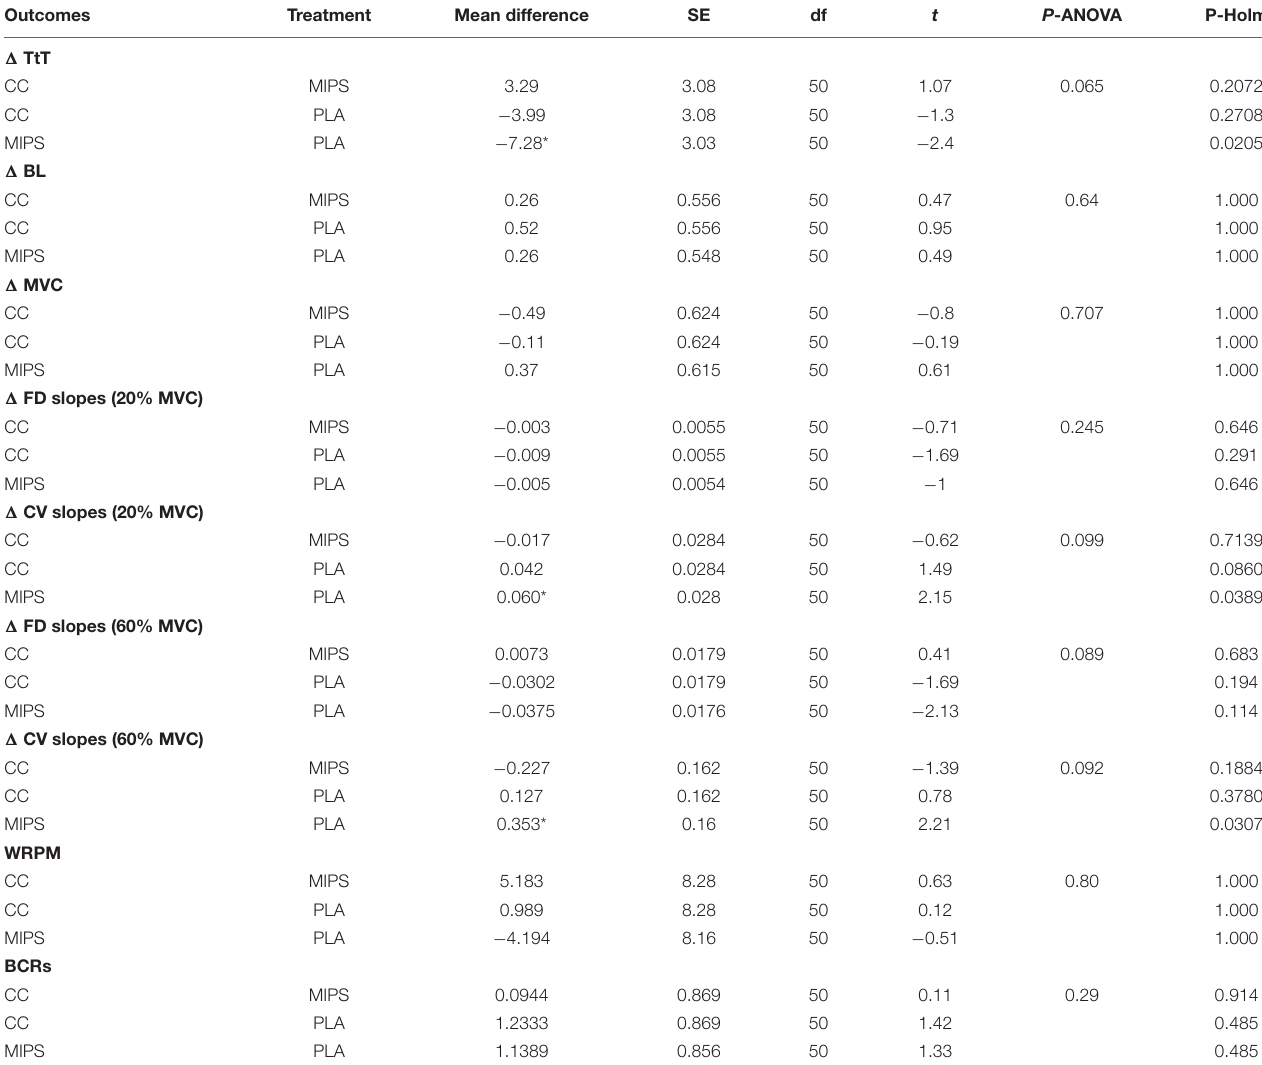
TABLE 3 | Treatments pairwise comparison analysis “condition vs. condition” on pre–post mean differences of (cid:49) values of the outcomes investigated. Outcomes Treatment Mean difference SE df t P -ANOVA